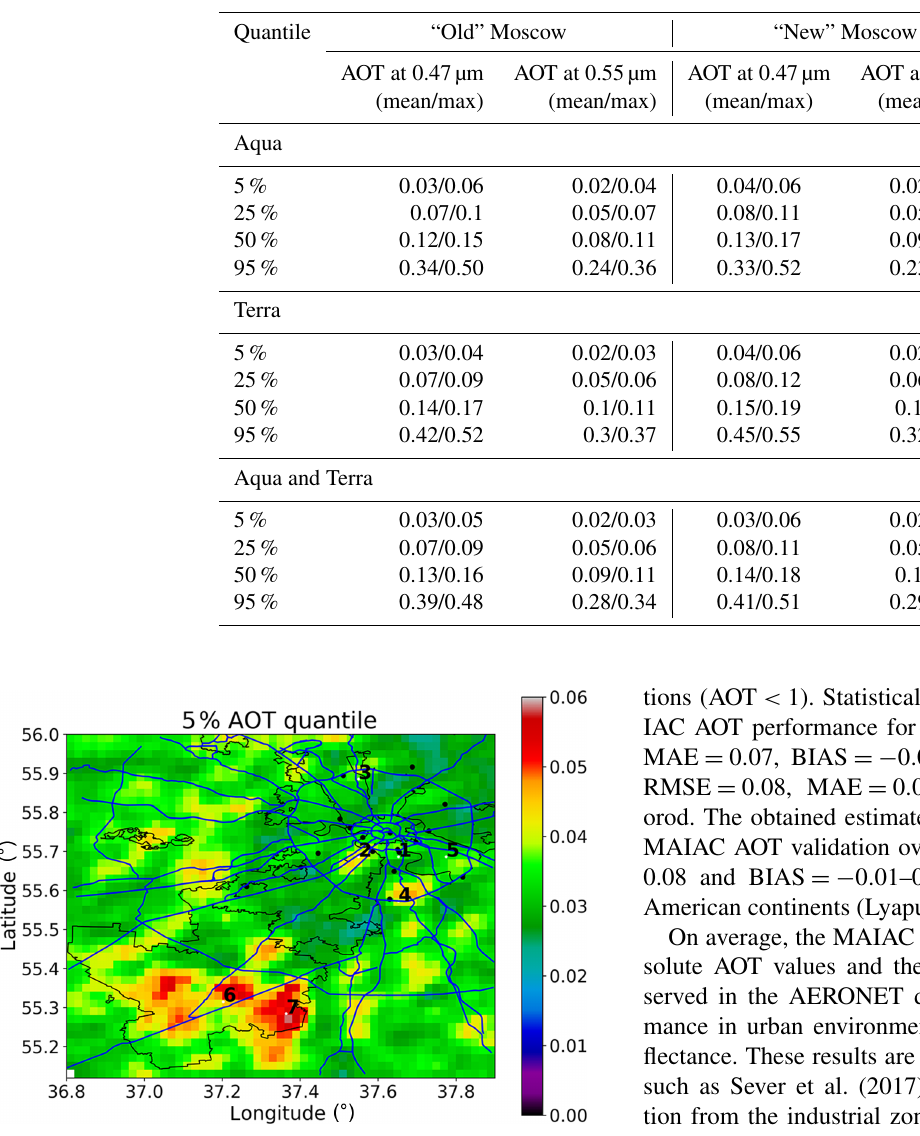
Figure 12. The 5% quantile of AOT at 0.47µm, 2001–2017. Points on map: 1, 3, 5: industrial zones with building construction area; 2, 4: highways; 6, 7: